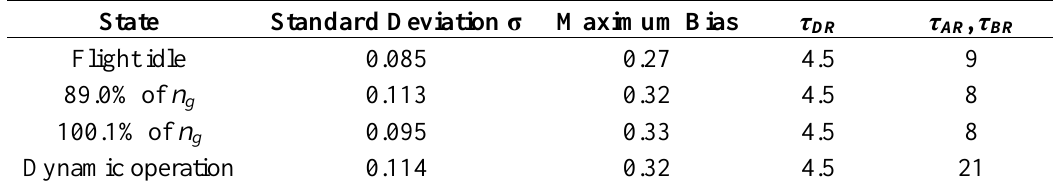
for the turbo-shaft 45